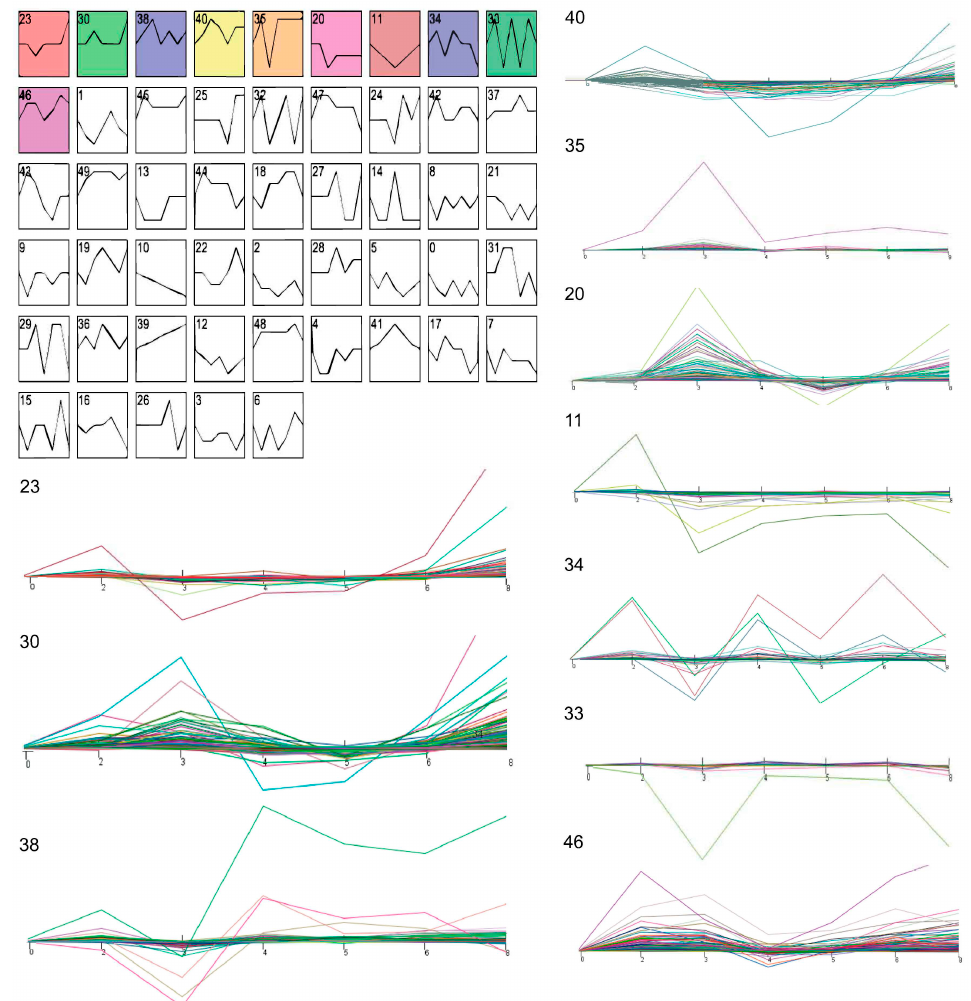
Figure 1. STEM analysis identified ten significant chronological profiles in gene expression, which are depicted graphically.